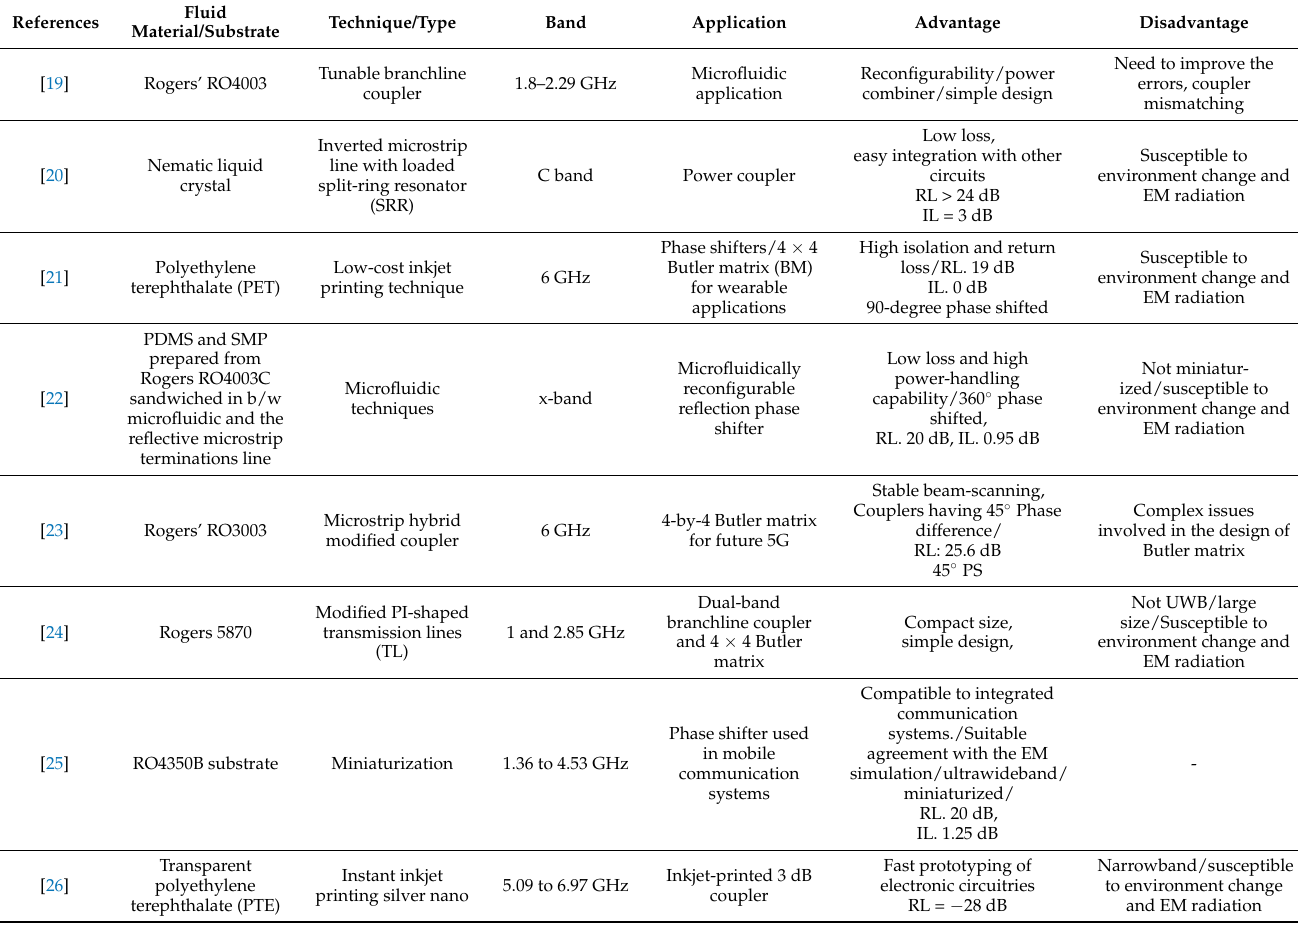
Figure 5. A picture of the 3 dB branchline coupler. Table 1. Comparison analysis of fluidic coupler, power divider, and phase shifters.